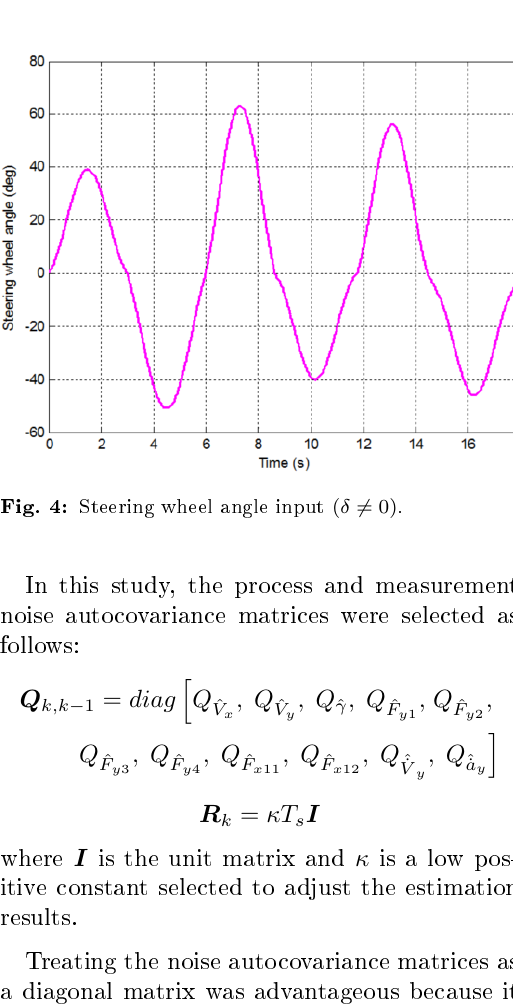
Fig. 5, errors existed between the calculated ver- tical forces from Eqs. (35)(cid:21)(38) and the